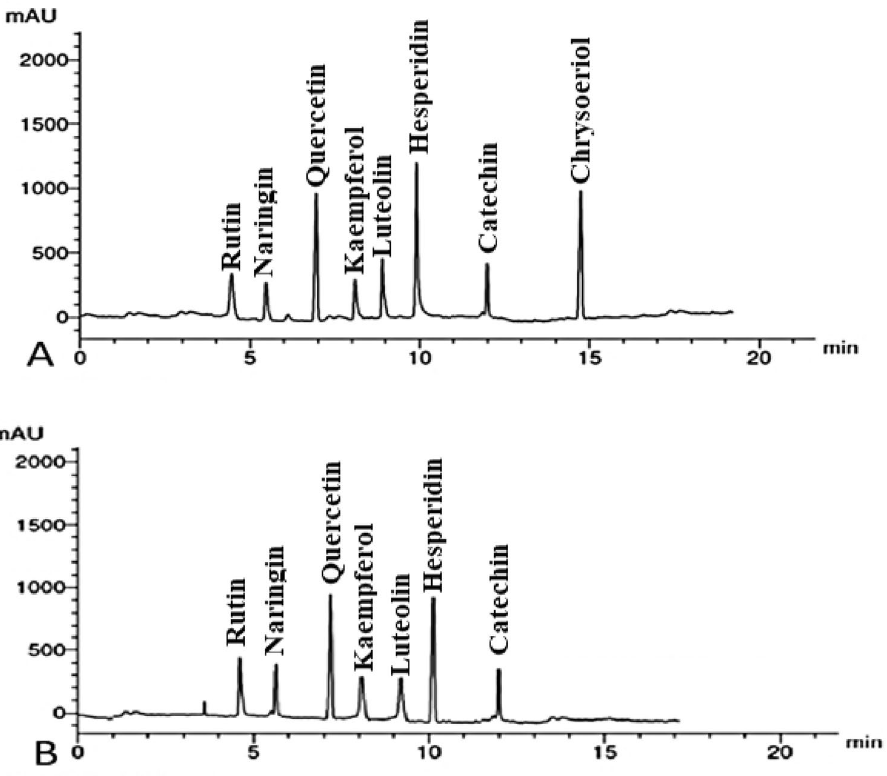
Figure 5. HPLC chromatograms of flavonoid compounds identified in the methanol leaf extracts of U. dioica ( A ) and D. viscosa ( B ).